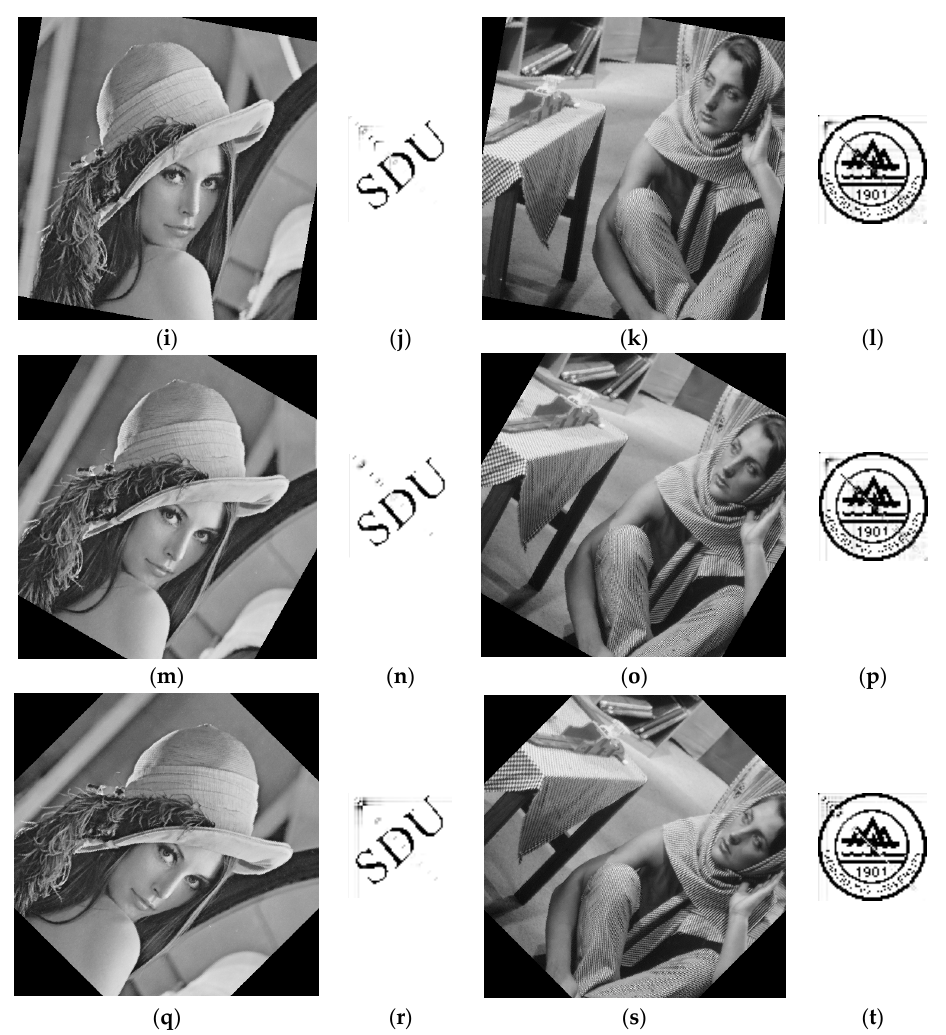
Figure 16. Watermarked images and extracted watermarks under rotation: ( a ) rotated Lena (2 ◦ ); ( b ) extracted watermark w 1 ; ( c ) rotated Barbara (2 ◦ ); ( d ) extracted watermark w 2 ; ( e ) rotated Lena (5 ◦ ); ( f ) extracted watermark w 1 ; ( g ) rotated Barbara (5 ◦ ); ( h ) extracted watermark w 2 ; ( i ) rotated Lena (10 ◦ ); ( j ) extracted watermark w 1 ; ( k ) rotated Barbara (10 ◦ ); ( l ) extracted watermark w 2 ; ( m ) rotated Lena (30 ◦ ); ( n ) extracted watermark w 1 ; ( o ) rotated Barbara (30 ◦ ); ( p ) extracted watermark w 2 ; ( q )